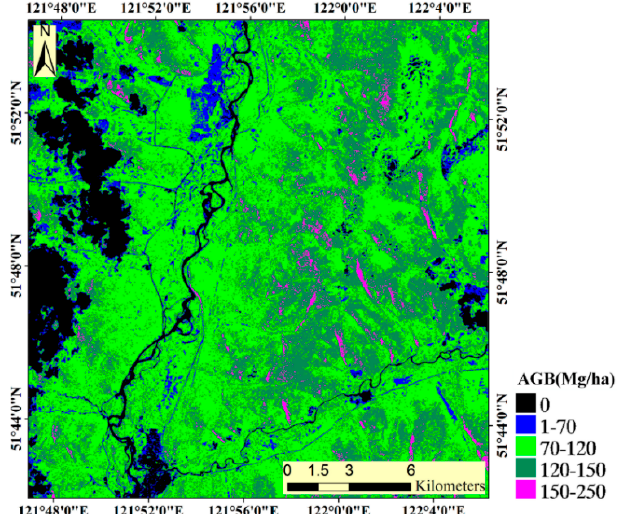
Figure 6. Wall-to-wall map of mean biomass estimates as obtained from the 100 bootstrapped model runs, using the COVI and residual optical and microwave optimal variables, random forest and largest sample size (models in Experiment 3).